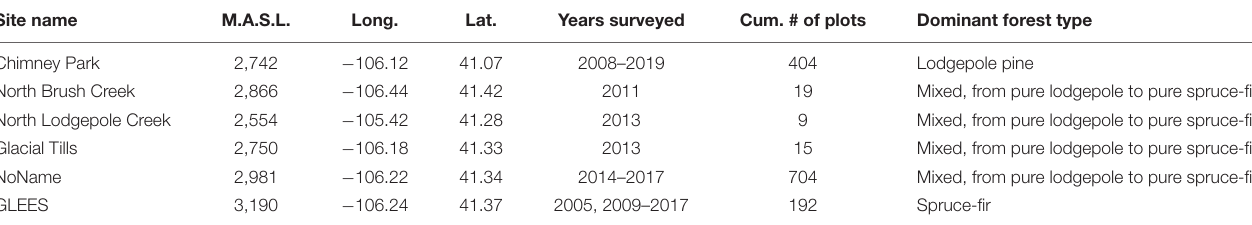
TABLE 1 | Overview of sampling sites, average elevation (meter above sea level; M.A.S.L.), general location (latitude and longitude), and the years in which plots were